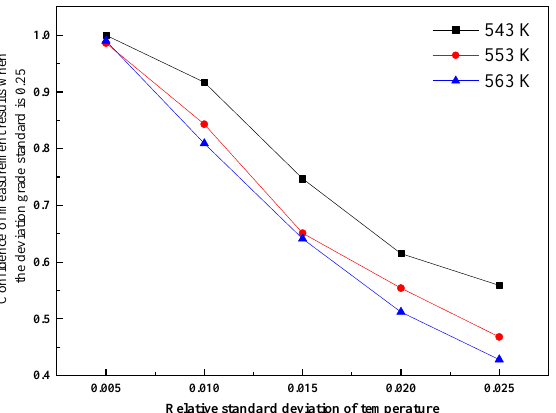
Figure 12. Relationship between relative standard deviation of temperature and confidence of measurement results at deviation grade standard of 0.25.